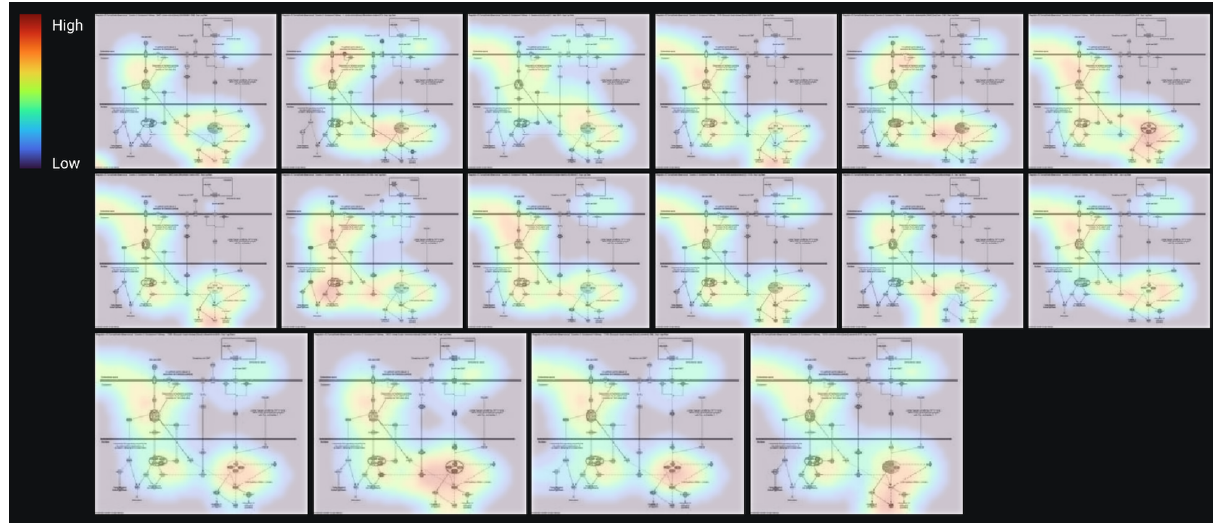
Figure 4. Activation map of AI modeling (DataRobot).